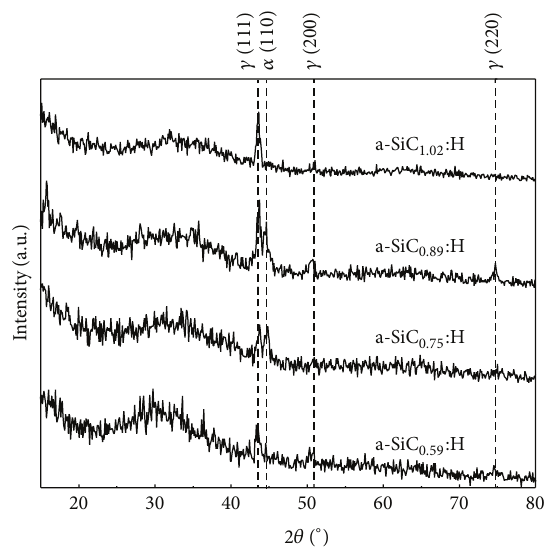
Figure 1: XRD spectra of a-SiC